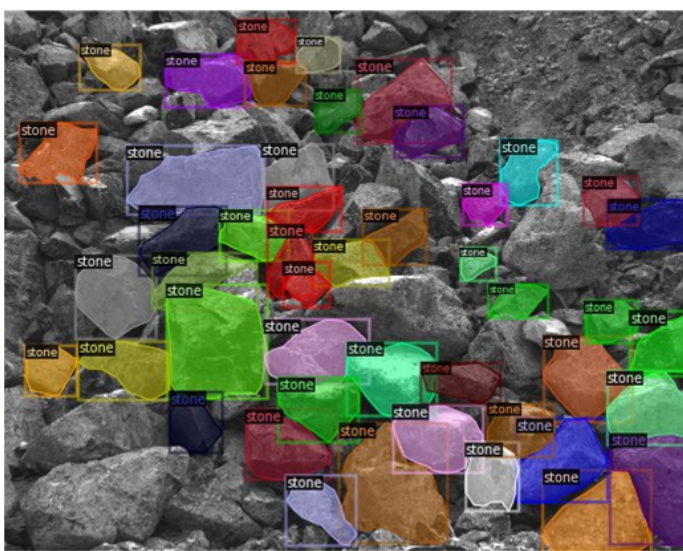
Figure 8. Typical image with the ground truth mask of rock